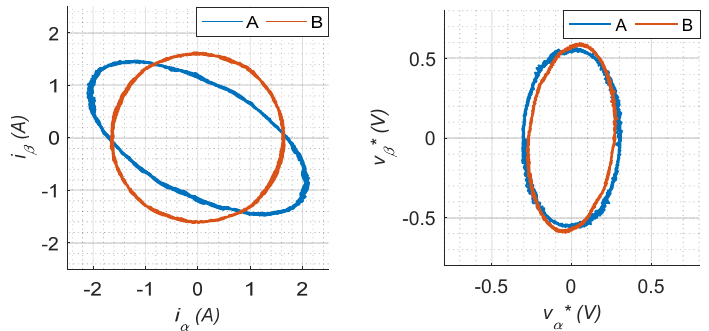
Figure 8. Trajectory of the current and voltage in α - β frame. A: before injection of feedforward, B: after injection of feedforward for three-phase IM.